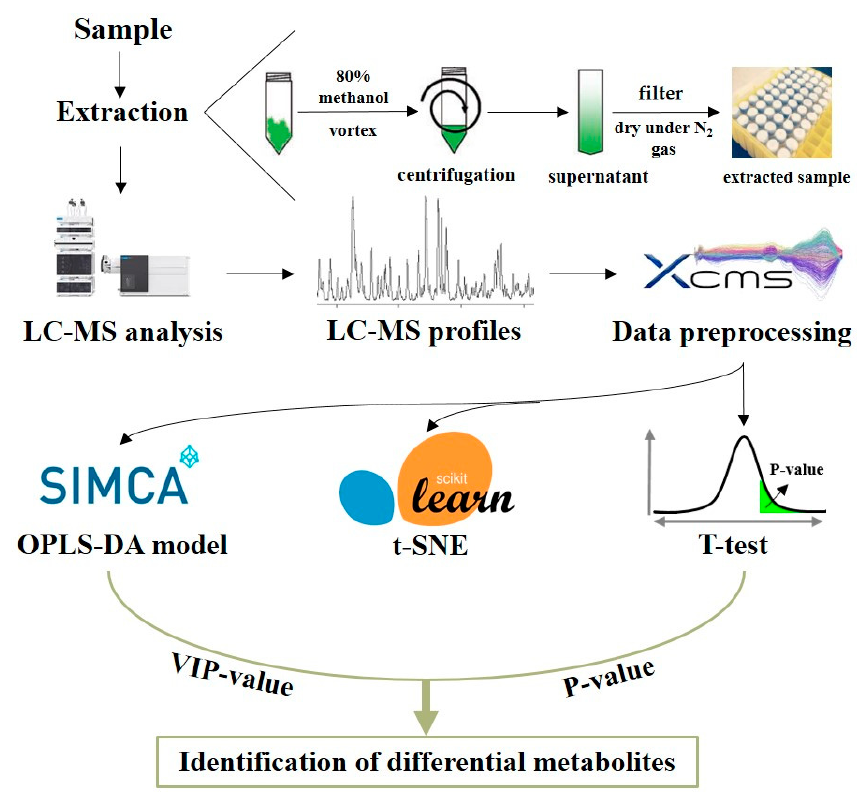
Scheme 1. Schematic diagram of untargeted metabolomic analysis of Nicotiana tabacum L. (NTL) leaves based on liquid chromatography mass spectrometry (LC-MS). The untargeted metabolomic analysis based on LC-MS are mainly divided into the following six parts: extraction of metabolites of NTL leaves of different maturity grades, LC-MS analysis of the extracted metabolites, data pre- processing of LC-MS raw data, dimensionality reduction and visualization based on peak table, classification of samples with different maturity grades based on peak table, and identification of different metabolites.